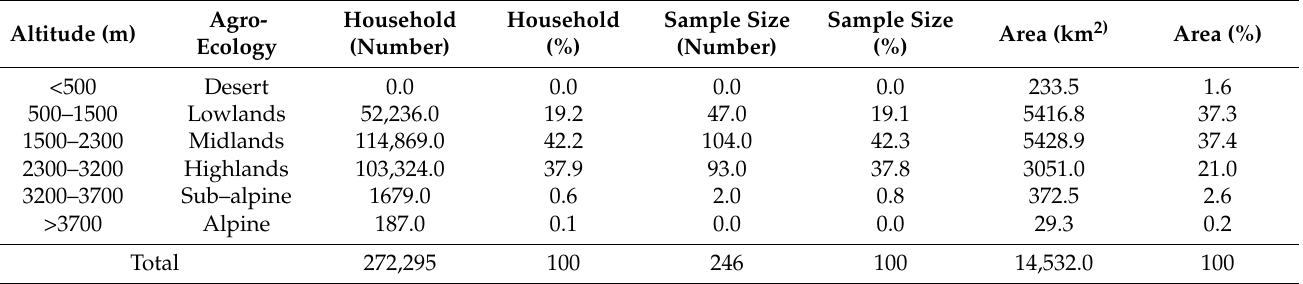
Table 2. Sample size and area coverage distributed across agro-climatology in Raya Valley, Southern Tigray,